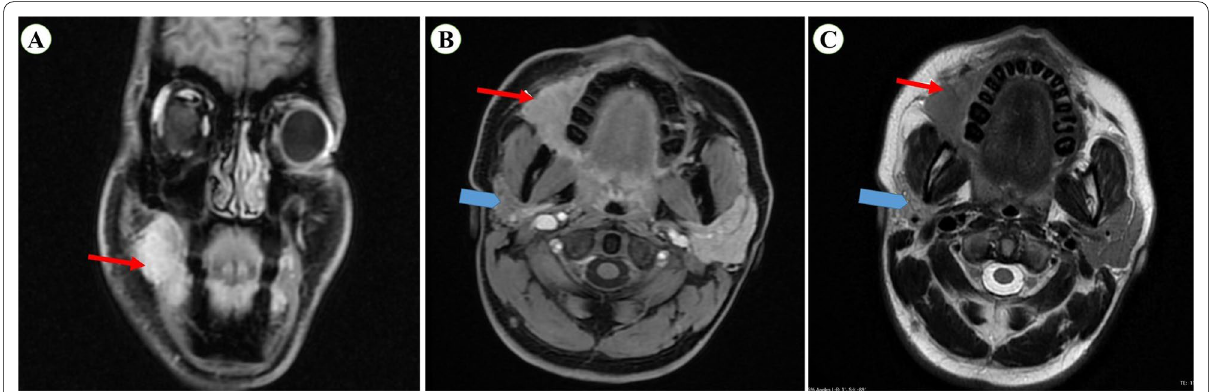
Fig. 1 MRI images— A Axial T2W, B Axial post-contrast T1W FS, and C coronal post-contrast T1WFS revealing an ill-defined enhancing soft tissue mass lesion involving right buccal mucosa, both upper and lower gingivobuccal sulcus, extending into retromolar trigone (red arrow— A , B , C ). The right parotid gland was small in size—atrophy (pentagon arrow— B , C